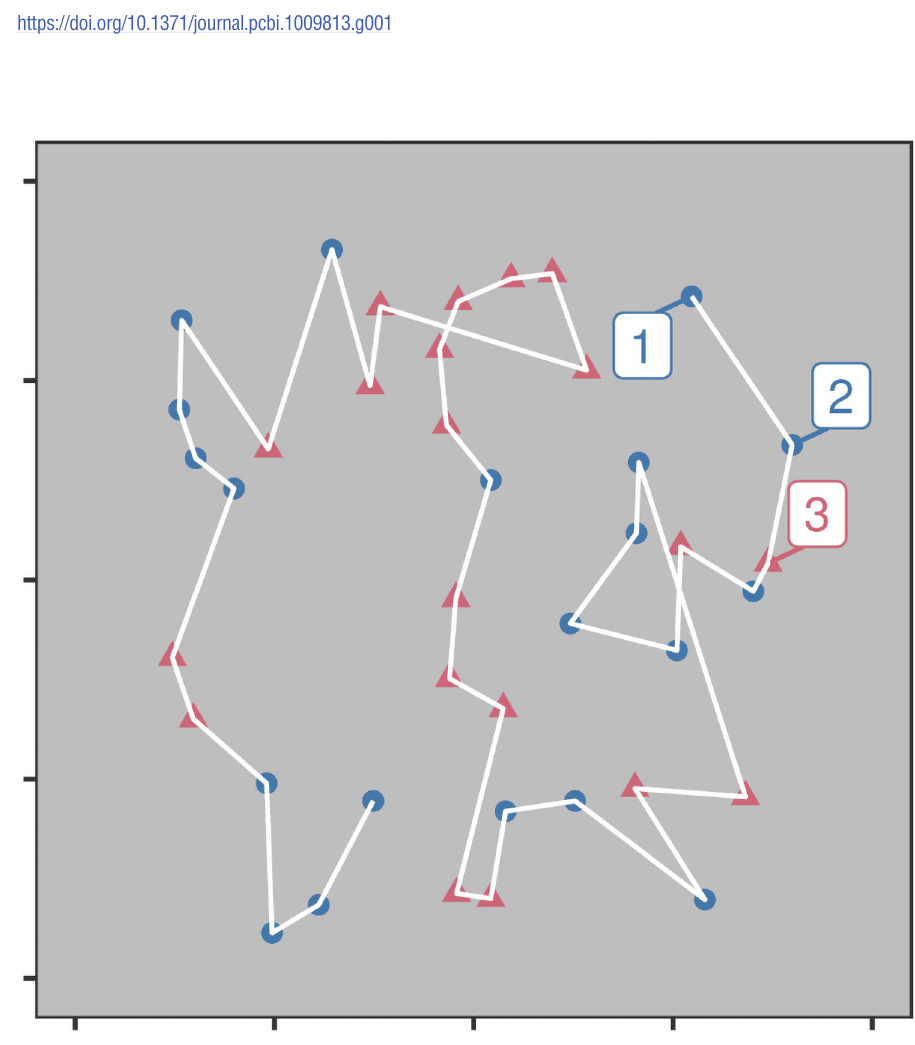
Fig 2. An example of how foraging tasks can be thought of as spatial, using example data from Kristja´nsson et al. (2014). The ‘path’ taken by the forager is indicated by the white line, with the numbers indicating the order of targets taken (first three selections